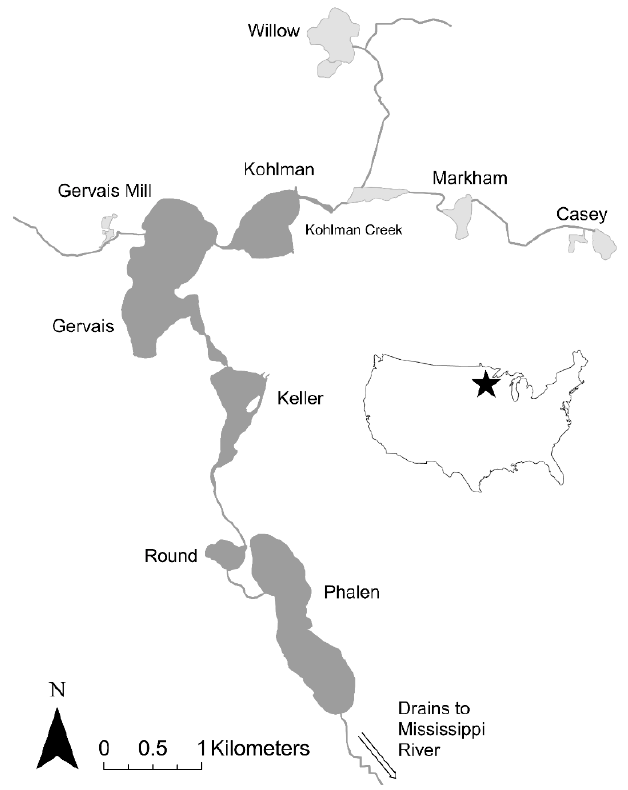
Figure 2. The Phalen Chain of